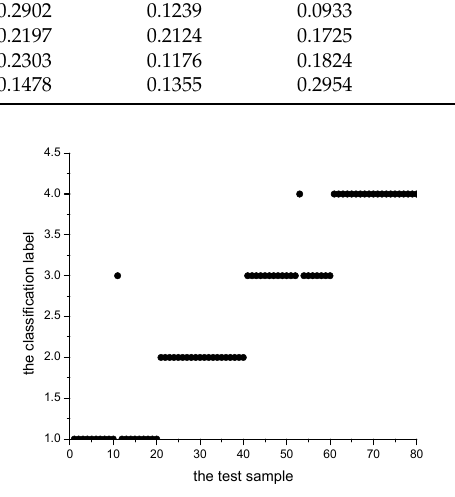
Figure 7. The classification of test samples.